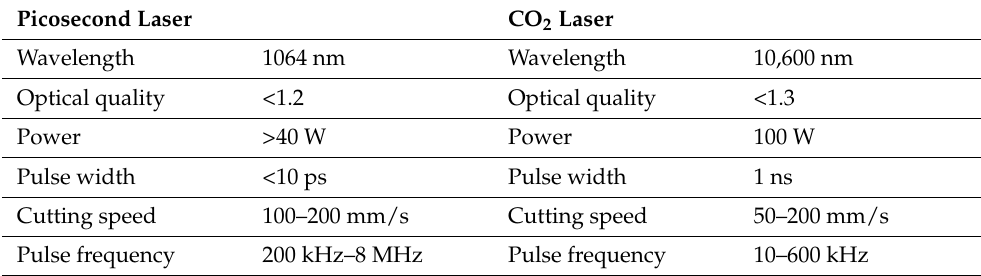
Table 3. Double-beam laser processing parameters.